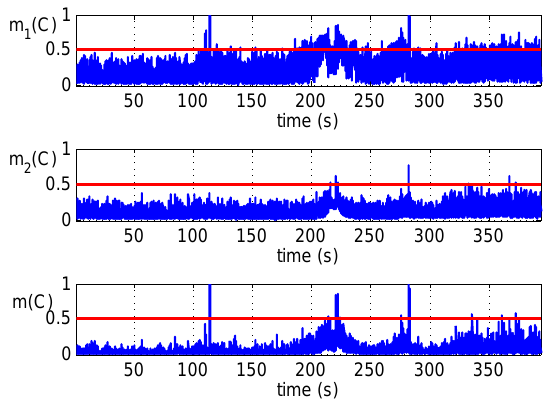
Figure 10. Detections’ fusion of the Scenario 4